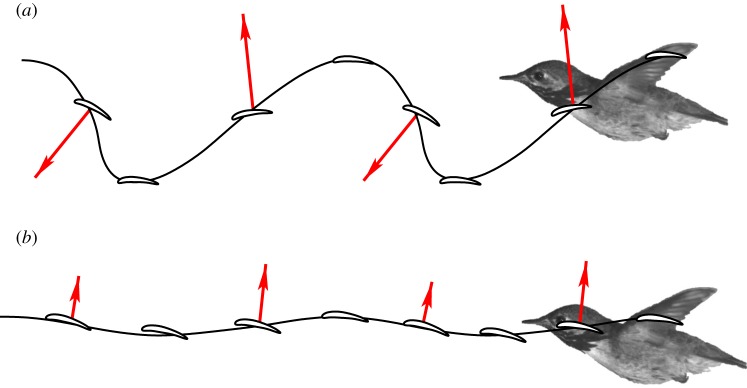
Time-dependent position of the distal chord (a) and proximal chord (b) in the global coordinate system with qualitative force production at mid-downstroke and mid-upstroke.